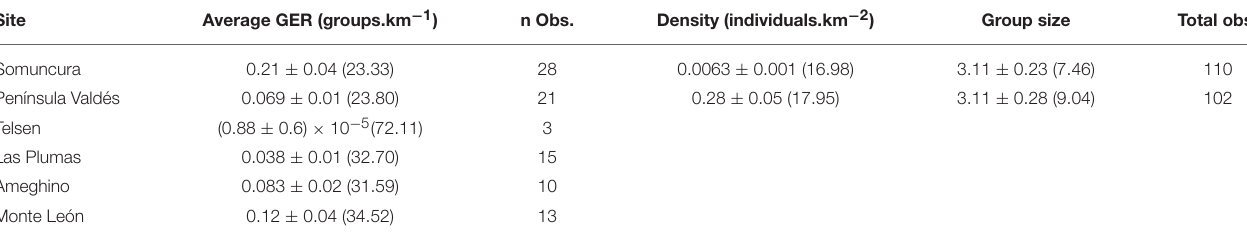
TABLE 3 | Abundance of lesser rheas expressed as average group encounter rate per site (Average GER) and population densities for Somuncura and Península Valdés, where the average number of adults per group (Group size) was also estimated.